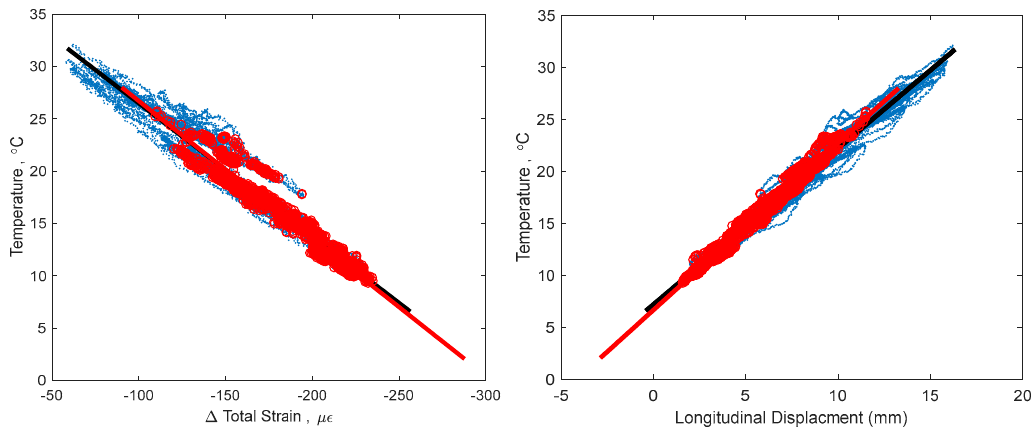
Figure 11. 2D projections of 3D signature, keeping temperature as the vertical axis. Red indicates time points of minimal thermal gradient found using MR = 4 °C/m, and red line indicates best fit line for points of minimal thermal gradient found using MR = 4 ◦ C/m, and red line indicates best fit line for minimal gradient data set, as in Figure 10. minimal gradient data set, as in Figure